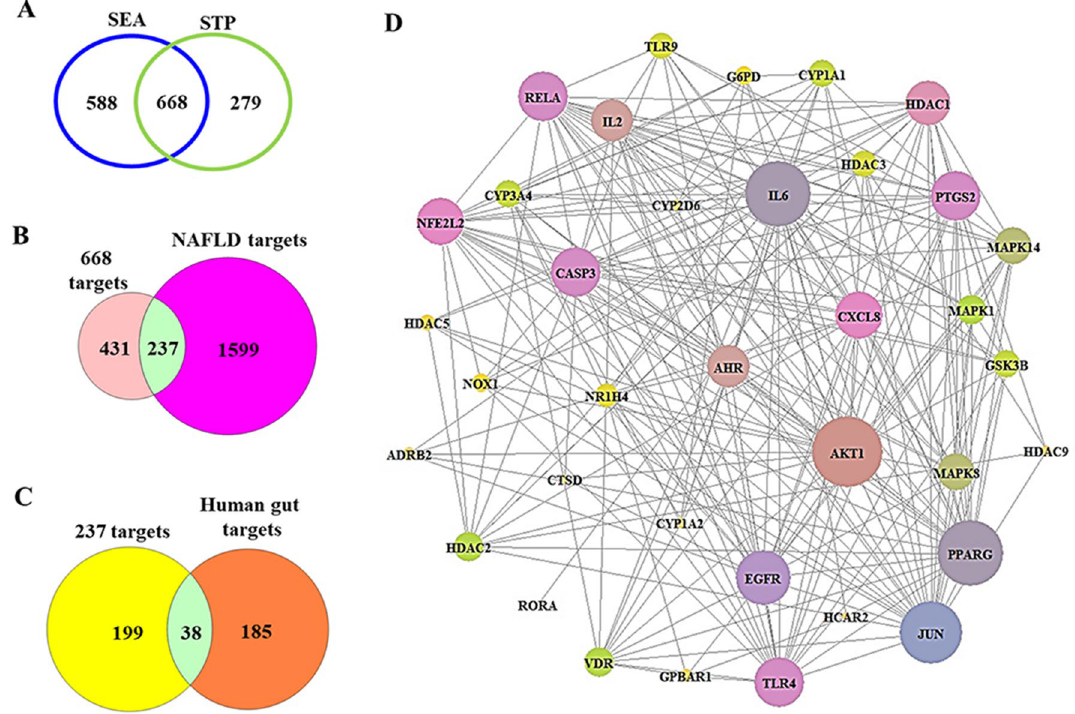
Figure 2. ( A ) The number of overlapping 668 targets between SEA and STP database. ( B ) The number of overlapping 237 targets between the 668 targets and NAFLD-related targets. ( C ) The number of the final overlapping 38 targets between the 237 targets and gut human targets. ( D ) The PPI networks (36 nodes and 237